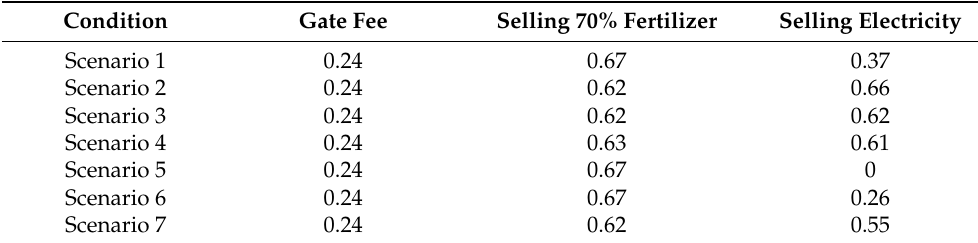
Table 14. The revenue of different scenarios during the first year.